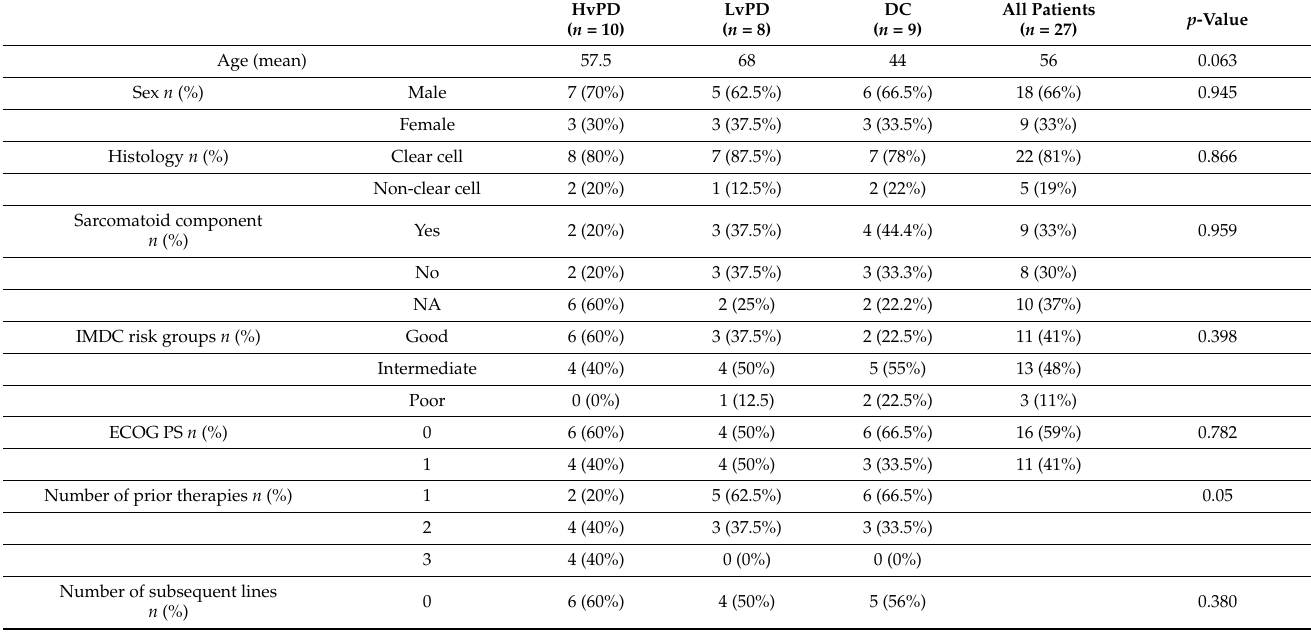
Table 1. The patients’ baseline characteristics and p -value for associations between DC, LvPD or HvPD and categorical or continuous variables. HvPD: Higher velocity PD; LvPD: Lower velocity PD; DC: Disease control; IMDC: Interna- tional Metastatic RCC Database Consortium; ECOG PS: Eastern Cooperative Oncology Group Performance Status; NA: Not